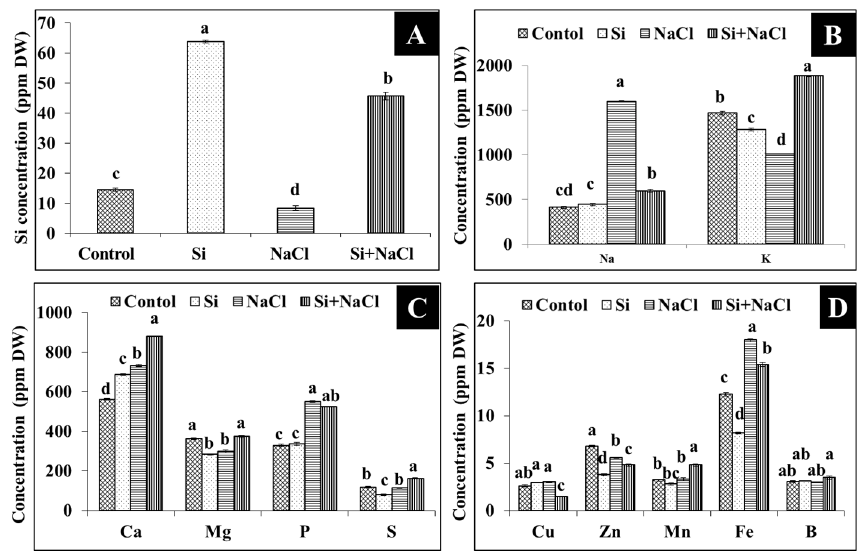
Figure 7. Content of silicon ( A ), sodium and potassium ( B ), and other macro- ( C ) and micro- ( D ) nutrients in response to salt stress with or without Si supplementation. Data are the mean ± SD from three replicates. Different letters indicate that the treatments are significantly different at p ≤ 0.05.